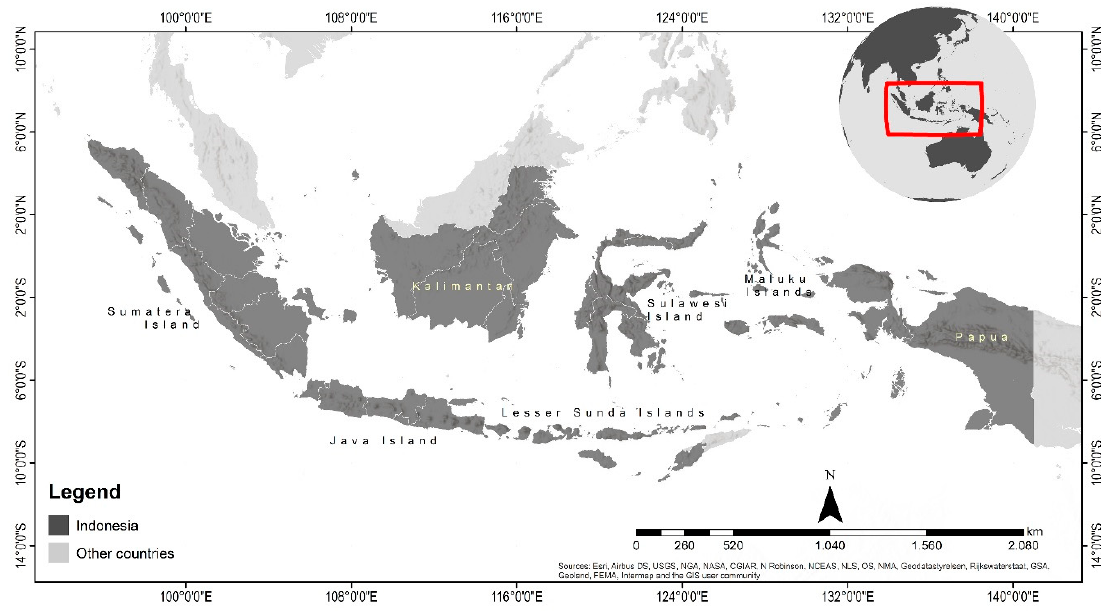
Figure 1. Overview of the study area in Indonesia.